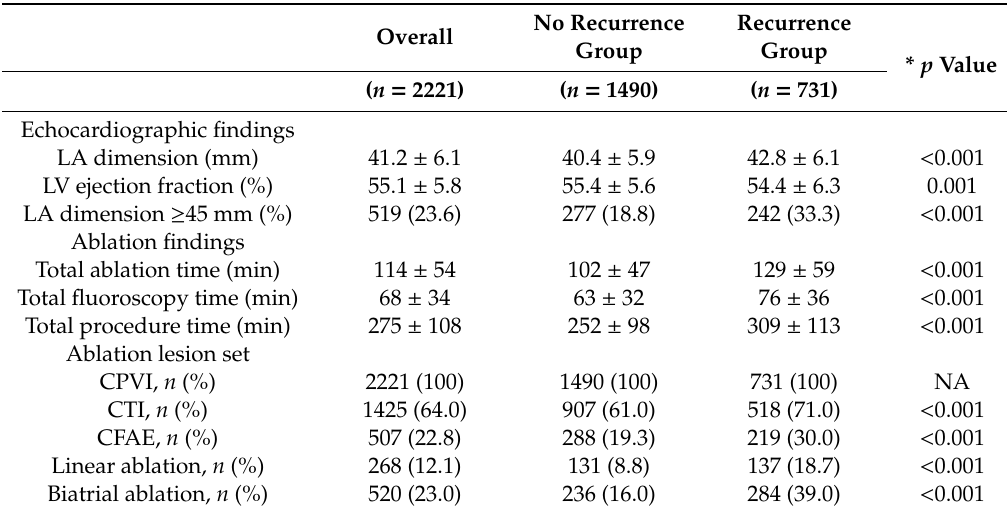
Table 2. Echocardiographic and ablation